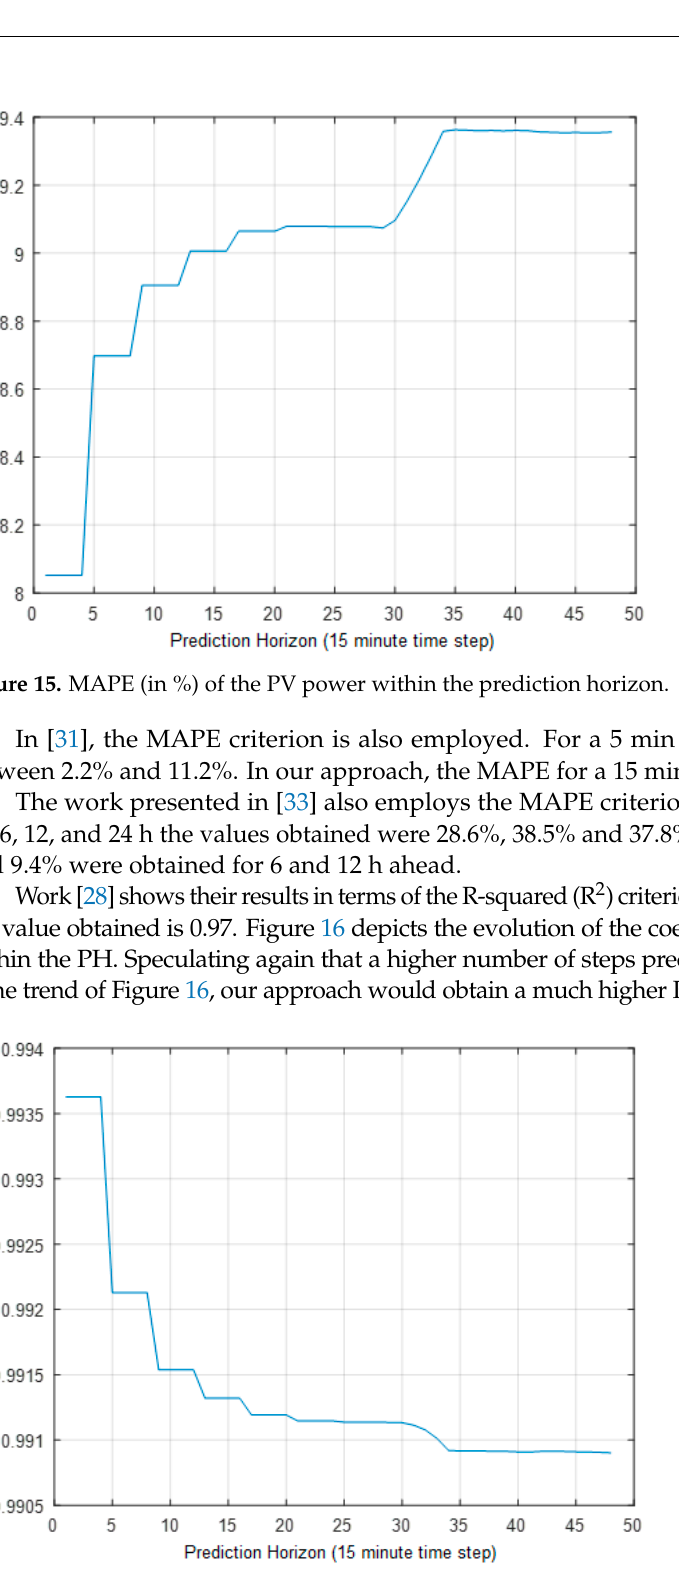
Figure 16. Coefficient of determination of the PV power within the prediction horizon. Work [32] uses a direct mode to supply multi-step ahead PV forecasts with a prediction horizon of 3 h, with steps of 15 min. Different models are designed for each season. For spring, summer, fall and winter, the coefficient of determination ranges from 0.998 to 0.918, 0.999 to 0.964, 0.996 to 0.907 and 0.997 to 0.905, respectively, between 15 min and 180 min ahead. Our second case uses data from spring and summer, with considerable better